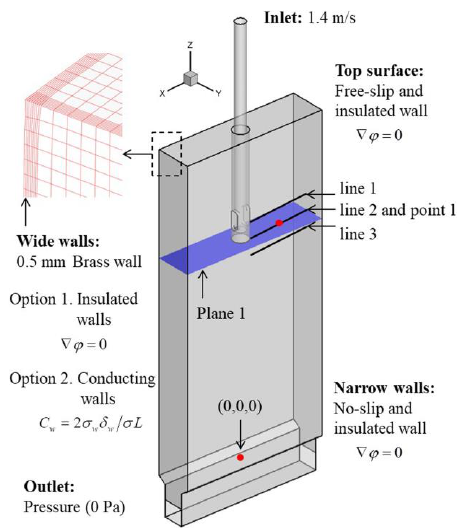
Figure 2. C omputational domain and boundary conditions. Figure 2. Computational domain and boundary